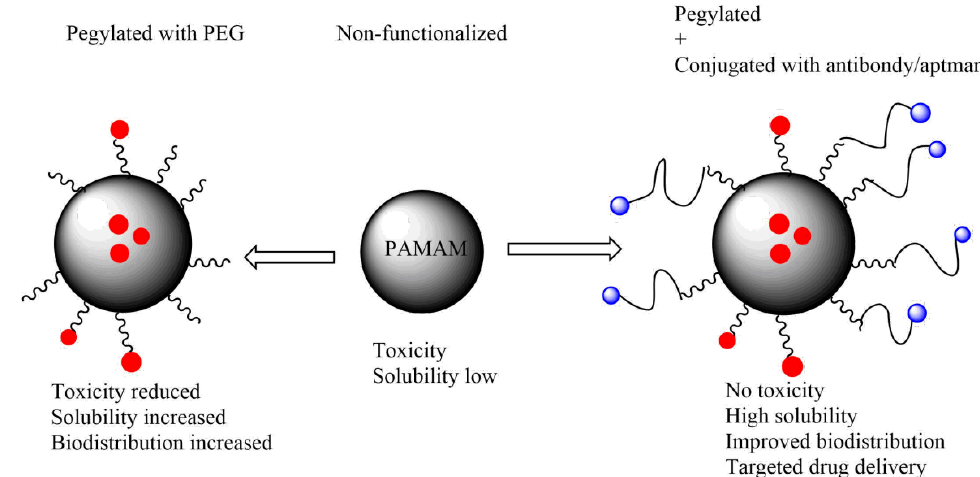
Figure 3. A cartoon showing the difference between non-functionalization PAMAM dendrimer, pegylated and pegylated PAMAM dendrimer conjugated with antibody/aptamer. Non-modified PAMAM dendrimer shows considerable toxicity when compared to functionalized. Pegylated PAMAM dendrimer shows improved solubility and biodistribution of encapsulated drugs, the antibody/aptamer conjugated PAMAM dendrimer has an added advantage of targeted drug delivery. Pegylated and conjugated PAMAM dendrimers represents a better drug delivery approach.